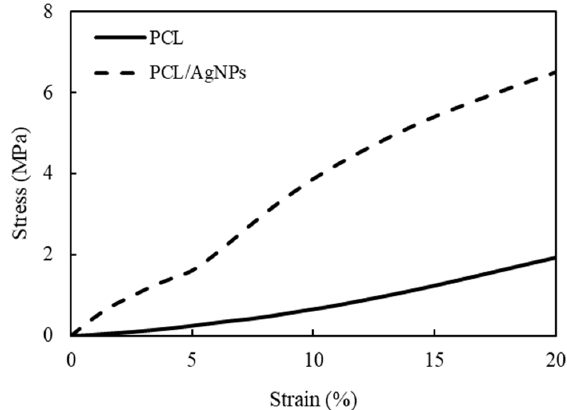
Table 4. Compressive Young’s modulus and compressive strength at 10% strain of the PCL and PCL/AgNPs scaffolds.